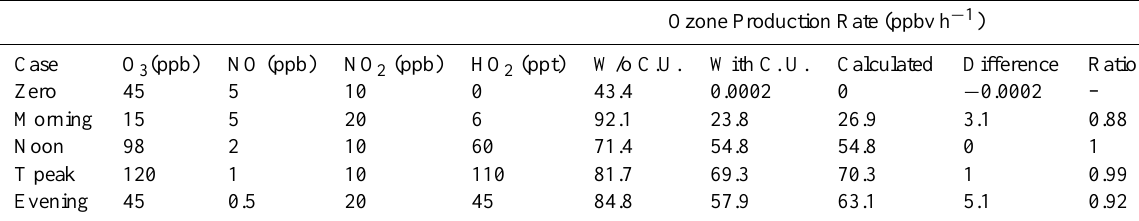
Table 3. Model results for ozone production (ppbvh − 1 ) without converter unit (W/o C.U.), with converter unit (With C.U.), and theoretically calculated. The last columns are the difference between calculated production rates and modeled results with the converter unit and the ratio of the model results with the converter unit to the calculated ozone production rate. The residence time in the chambers is 5.8 min while the residence time in the converter cells is 103 seconds. The photolysis frequency inside converter is 0.09 s − 1 . The photolysis frequency in the atmosphere is 0.008s − 1 at noon. For the morning and evening cases, J NO was assumed to be half of the noon 2